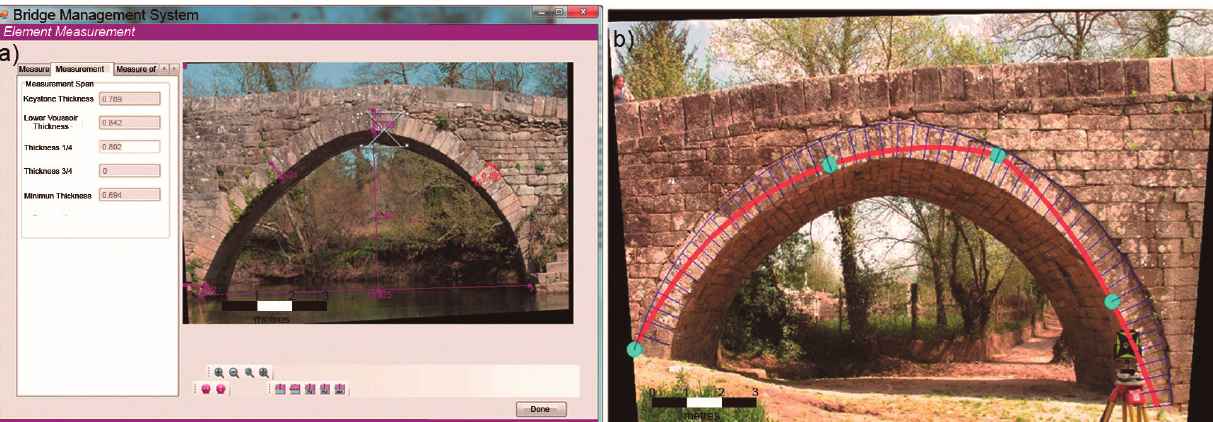
Figure 7. ( a ) Geometric inventory software inspection; ( b ) in situ structural assessment from image